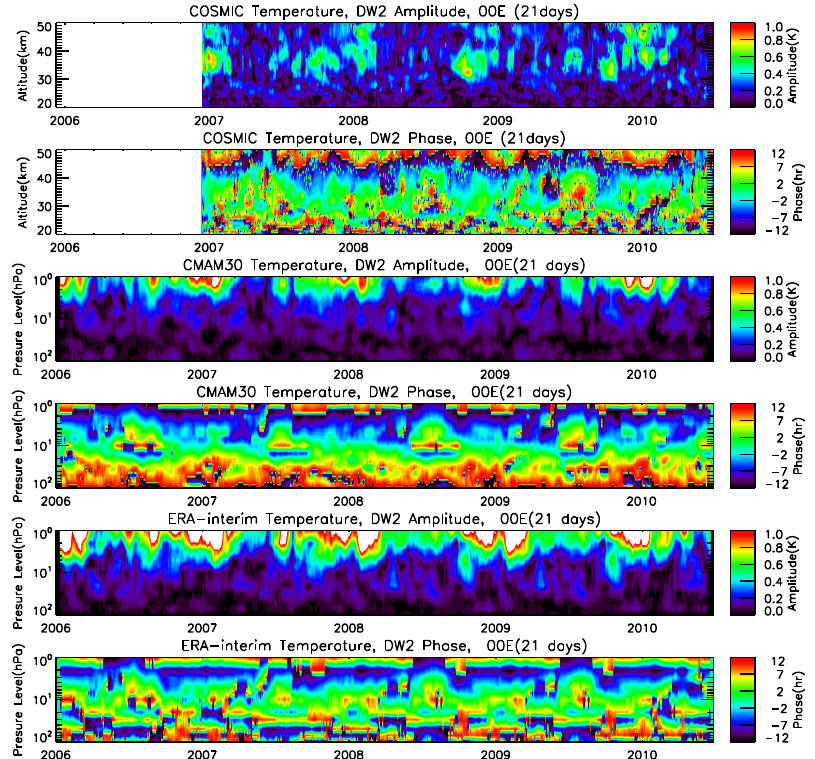
Figure 3. Amplitudes and phases of DW2 tide over equator from COSMIC observations, CMAM30, and ERA-interim reanalysis datasets using ± 10-day window.